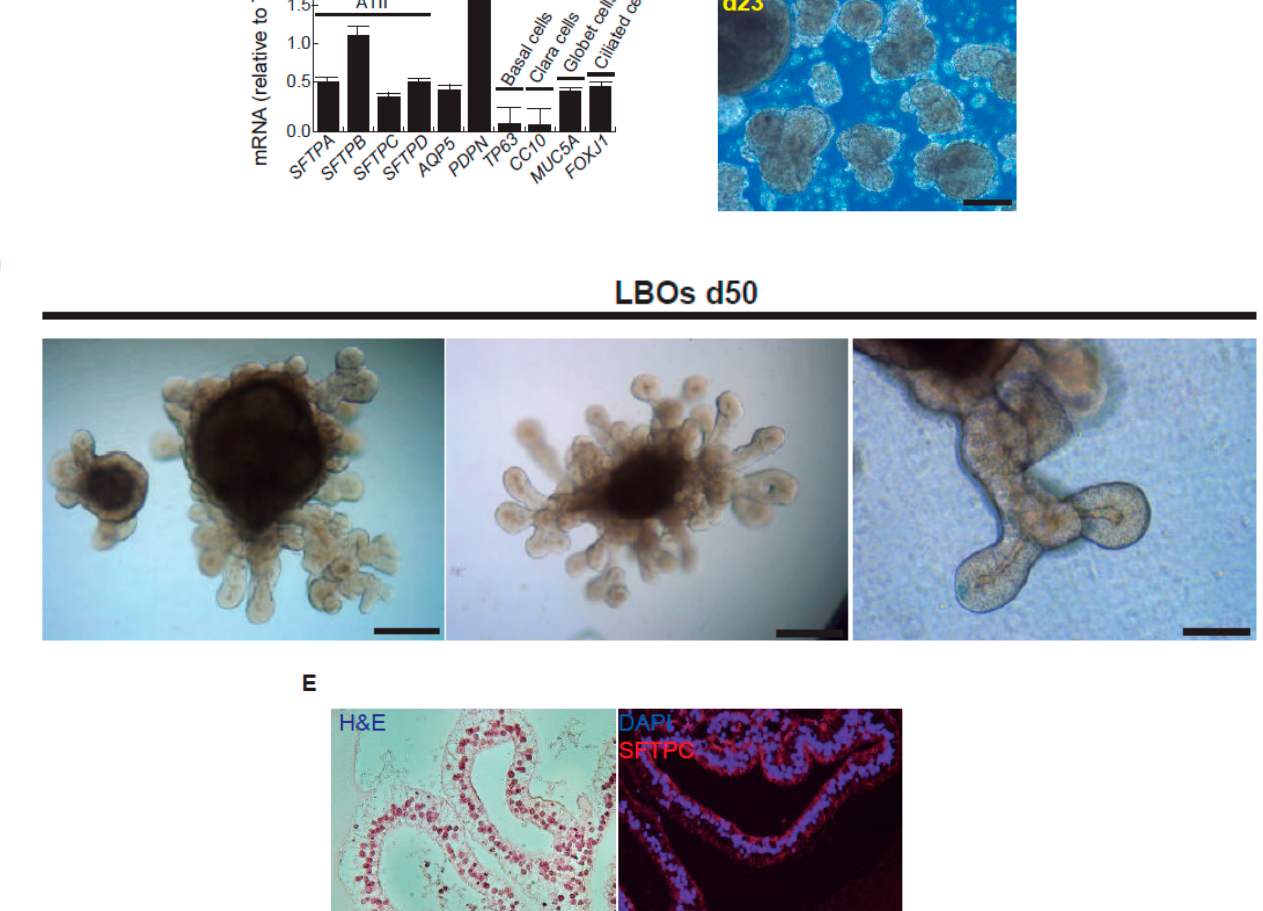
Figure 3. Representative micrographs of the sequential differentiation processes and expression markers. ( A ) Left upper micrograph: AND-2 colony growing along with feeder cells (inactivated MEFs (iMEFs)); scale bar: 100 μ m); central upper micrograph: expression of SOX2 (SRY (sex-determining region Y)-box 2) in an undifferentiated colony of AND-2; scale bar: 100 μ m. Right upper micrograph: representative micrograph of EBs (embryoid bodies). Bottom panels: AFE (anterior foregut endoderm) and representative micrographs of cultures at day 23 of differentiation (lung progenitors) and at day 60 (differentiated lung and airway cells); black arrowheads signal cells with a typical flat and crescent shape morphology denoting alveolar type I cells (ATI cells); scale bar: 100 μ m. ( B ) Levels of expression (relative to TBP (TATA box binding protein)) of lung and airway epithelial cells markers at day 60 ( n = 3; > 4 organoids per condition were used). ( C ) Representative micrograph of nascent organoids growing in suspension at day 23. ( D ) Representative micrograph of LBOs at day 50 embedded in Matrigel TM sandwiches; scale bar: 100 μ m and 50 μ m (micrograph on the right). ( E ) Micrograph on the left: histochemical analysis of LBO sections (H&E staining); representative micrograph of an immunohistochemical staining of LBO sections (micrograph on the right) with an SFTP-C antibody. Scale bar: 100 μ m.